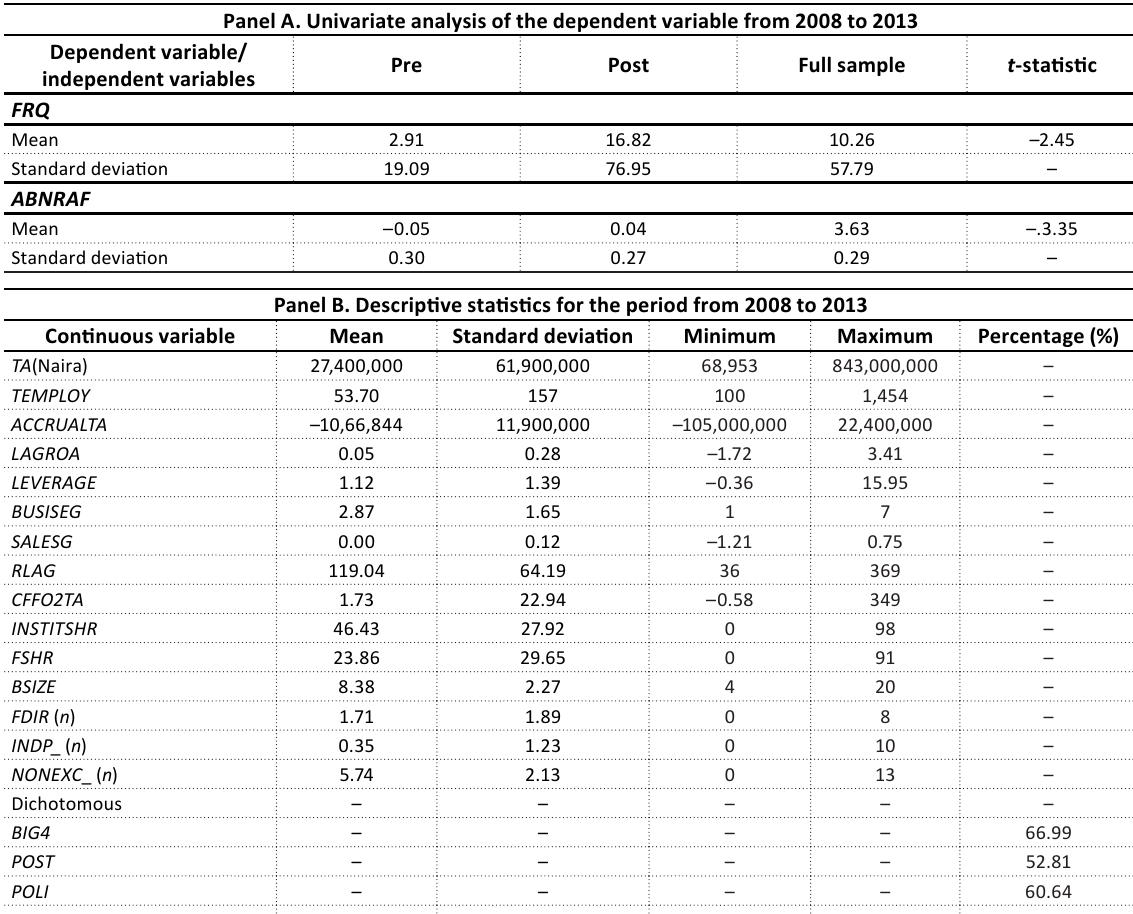
Panel B. Descriptive statistics for the period from 2008 to